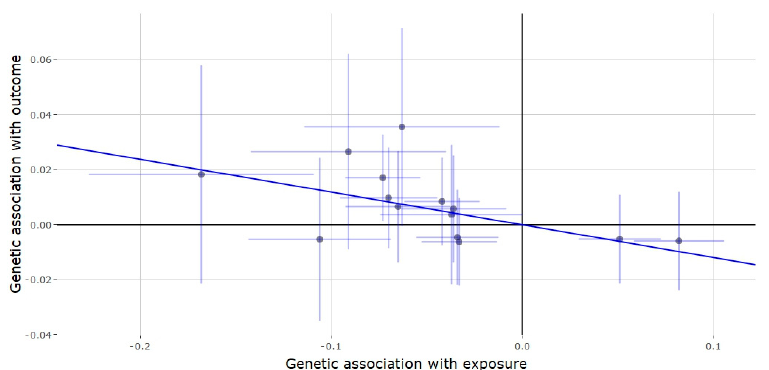
Figure 6. Genetic association of type II diabetes (T2D) against genetic association of testosterone ( SHBG locus). The slope (dark blue line) represents the causal association of testosterone with T2D (generated via inverse variance weighted Mendelian randomization), while the points on the plot and the lights around them (light blue lines) represent the SNP and its confidence intervals.